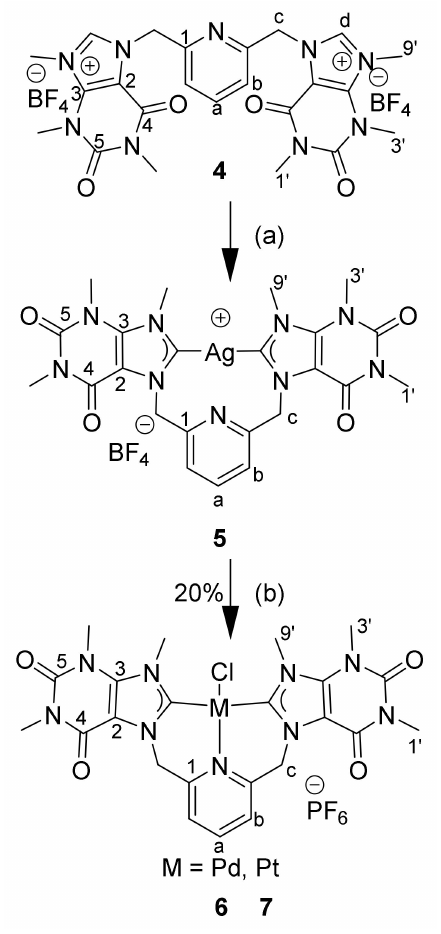
Scheme 3. Schematic synthesis of the metal complexes ( 5, 6 and 7 ), ( a ) Ag 2 O, CH 3 CN, CH 2 Cl 2 , 50 ◦ C; ( b ) PdCl 2 or K 2 PtCl 4 , CH 3 CN, 60 ◦